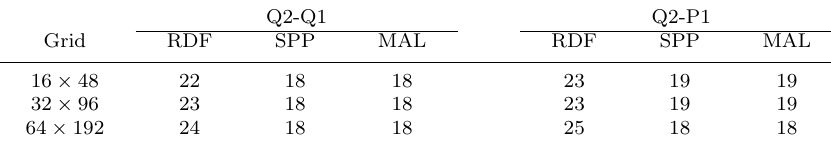
Table 10. Number of GMRES(20) iterations with the RDF, MAL and SPP preconditioners for steady backward facing step problem (uniform grids), the iteration counts are based on the experimentally optimal parameters. Q2-Q1 Q2-P1 Grid RDF SPP MAL RDF SPP MAL 16 ×